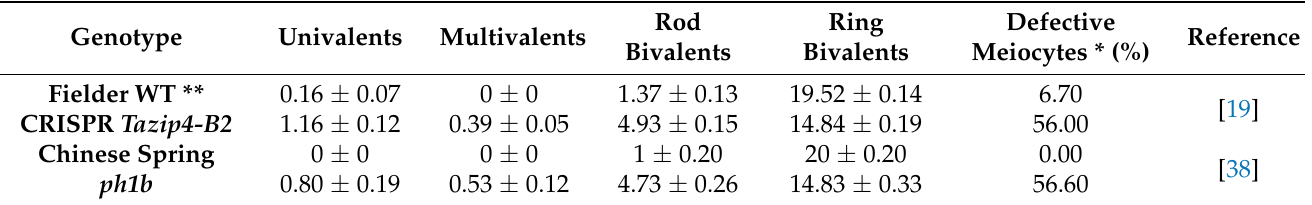
Table 1. Summary of the meiotic scores for the two Tazip4-B2 mutants and their corresponding wild